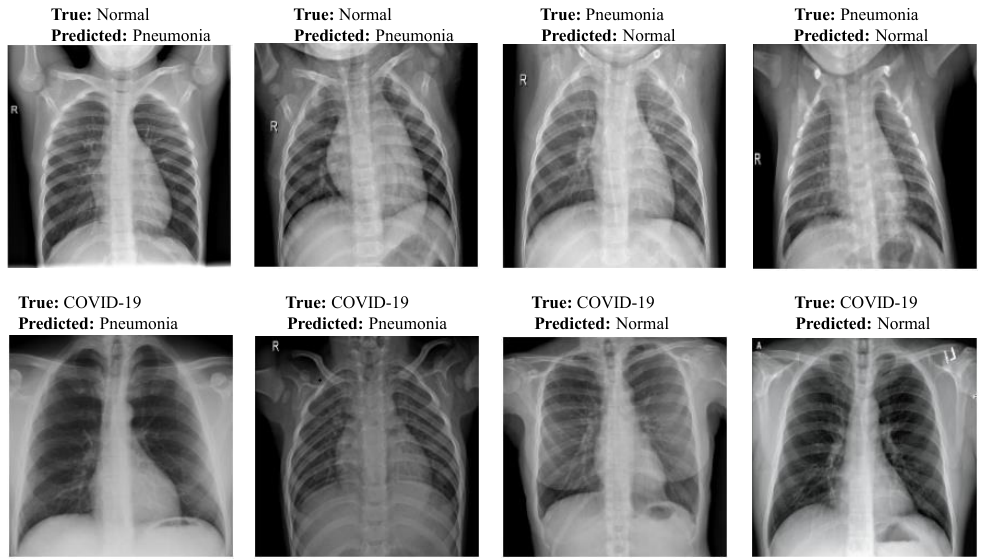
Figure 13. Sample misclassification outcomes of LW-CORONet.